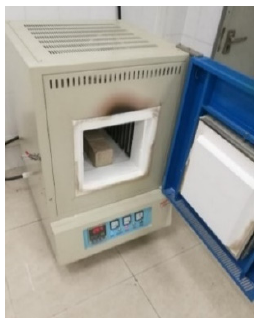
Figure 5. Muffle furnace with the function of programming control. Figure 5. Mu ffl e furnace with the function of programming